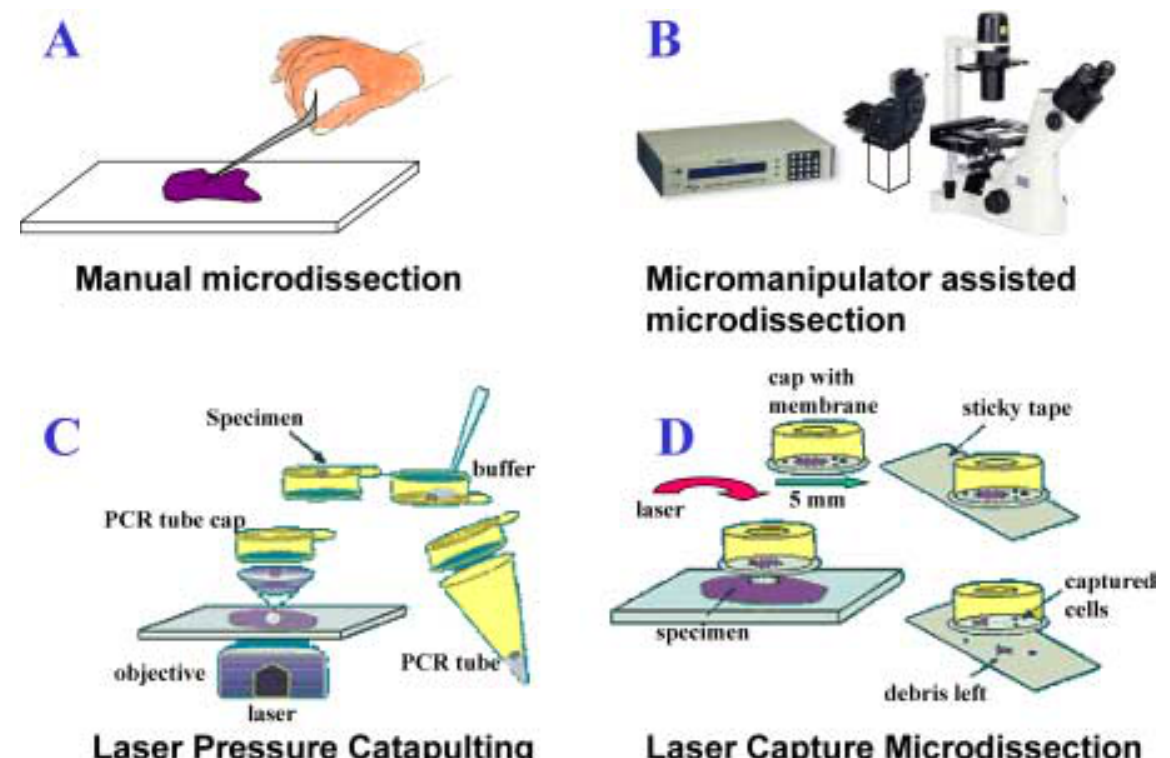
Fig. 2. A: Manual microdissection with surgical needle, w. or w/o optical magnification; B: Mechanical microdissection with joystick-operated robotic micromanipulator and inverted microscope; C: Laser-assisted microdissection using the laser to cut the sample and to transfer desired parts into tube mounted above the slide; D: Laser-assisted microdissection using foil-mounted tissue sections. This figure can be viewed on